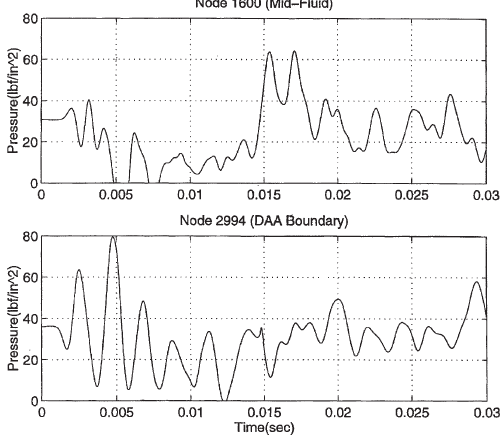
Fig. 12. Fluid pressure responses at the middle and bottom of CFA volume elements time compared to the Bleich–Sandler case with an ap- preciably larger pressure peak, 41% of the initial pres- sure wave. When the CFA is turned off, extremely high incident shock pressures at early time and small pres- sure variation at late time are observed as shown in Fig.